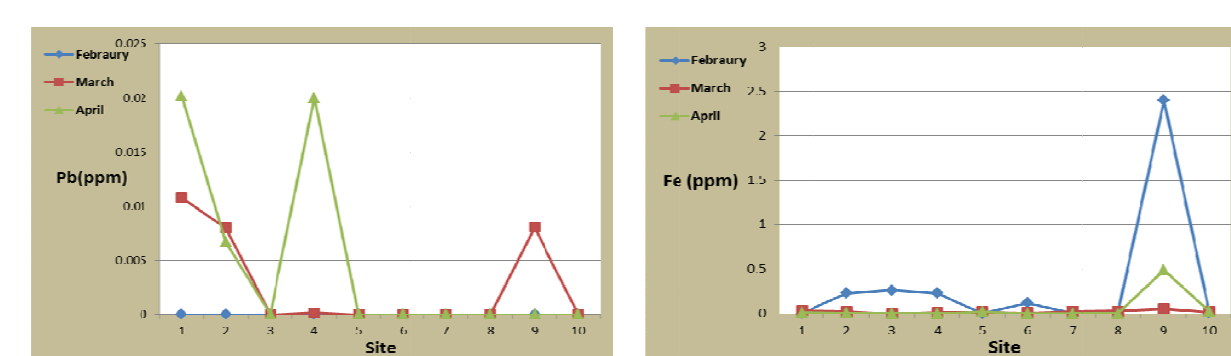
al Conductiv vity